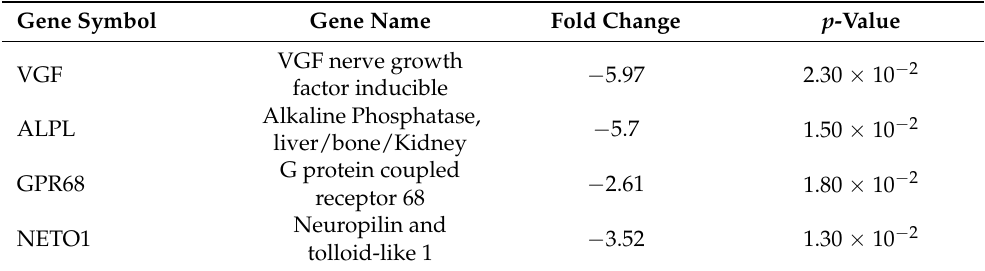
Figure 1. Comparison of the gene expression profile of GASC-LS (n = 6) versus GASC-SS (n = 5), using a customized RT2 PCR Array. Volcano plot shows the gene expression changes of 78 protein-coding transcripts analyzed using the RT2 Profiler™ PCR Array. The volcano plot highlights significant gene expression changes by plotting the log2 of the fold changes in gene expression on the x -axis versus their statistical significance on the y -axis. The center vertical line indicates unchanged gene expression, while the two outer vertical lines indicate the selected fold regulation threshold (abs ( ≥ 2)). The horizontal line indicates the selected p -value threshold ( p ≤ 0,05). Genes with data points in the far upper left (down-regulated, green dots) and far upper right (up-regulated, red dots) sections meet the selected fold regulation and p -value thresholds. Table 3. Comparison of genes differentially expressed in GASC-LS versus GASC-SS. The table shows genes with a significant down-regulation in GASC-LS compared to GASC-SS. Values indicate Fold Regulation calculated using the formula (2 ( − ∆∆ Ct ) ), i.e., the normalized gene expression (2 ( − ∆ Ct ) ) in the test sample (GASC-LS) divided by the normalized gene expression (2 ( − ∆ Ct ) ) in the control sample (GASC-SS). p -values are calculated based on a Student’s t-test of the replicate 2 ( − ∆ Ct ) values for each gene in the control and test